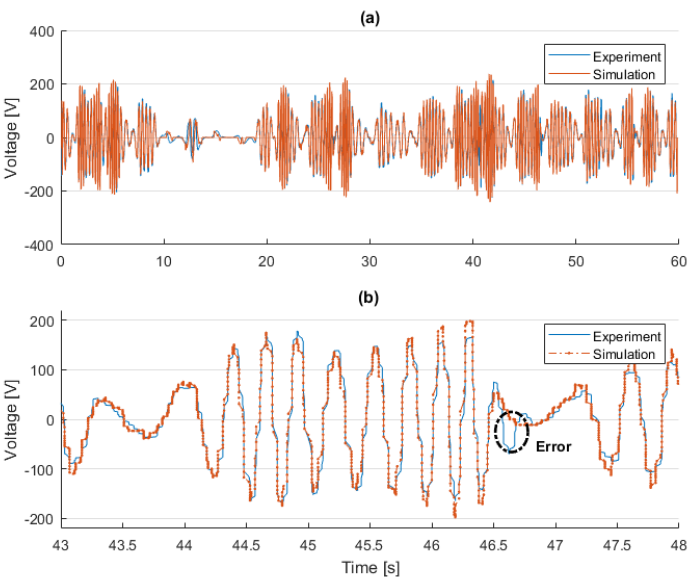
Figure 6. Phase voltage generated from the linear generator model: ( a ) Comparison of the phase voltage of simulation with the experimental result; ( b ) a draw-out from ( a ) with a duration of 5 s. The verification of the WEC model was also published in [12].